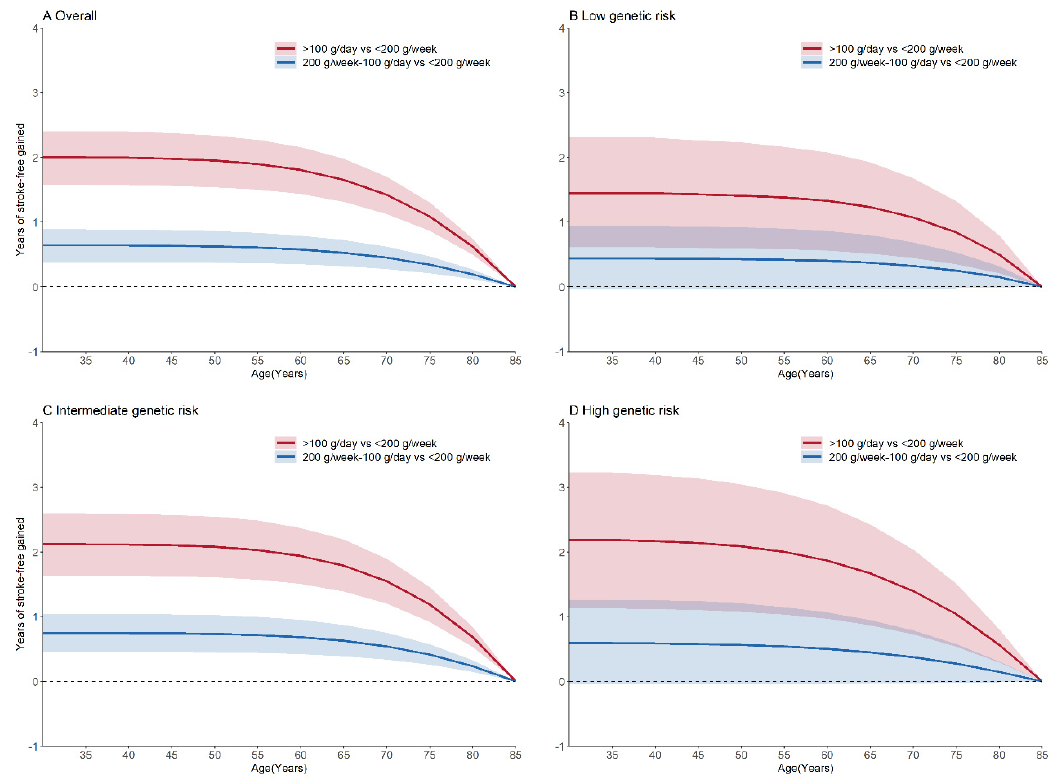
Figure 3. Stroke-free years gained associated with the fruit intake. The overall genetic risk for stroke was defined as high (quintile 5 of PRS), intermediate (quintile 2–4 of PRS), and low (quintile 1 of PRS). Models were adjusted for the cohort, age, sex, region, urbanization, education level, current smoking status, alcohol drinking status, physical activity, body mass index, diet score, and vegetables intake. Abbreviations: PRS, polygenic risk score.